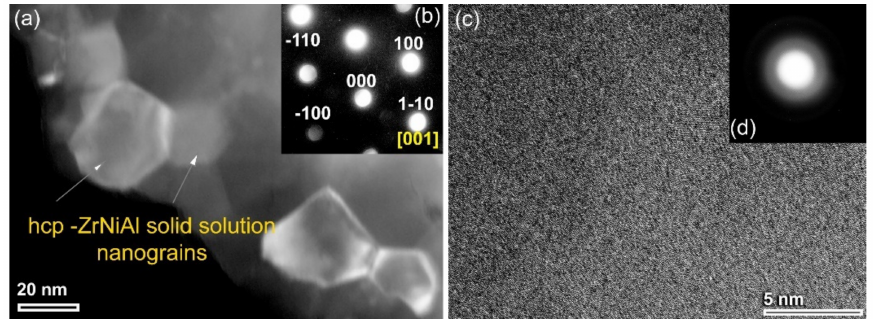
Figure 2. The field-emission high-resolution transmission electron microscope (FE-HRTEM) images and corresponding nanobeam diffraction patterns (NBDPs) of MA-Zr 75 Ni 25 Al 5 powders milled for 6 h and 25 h are displayed in ( a , b ) and ( c , d ),